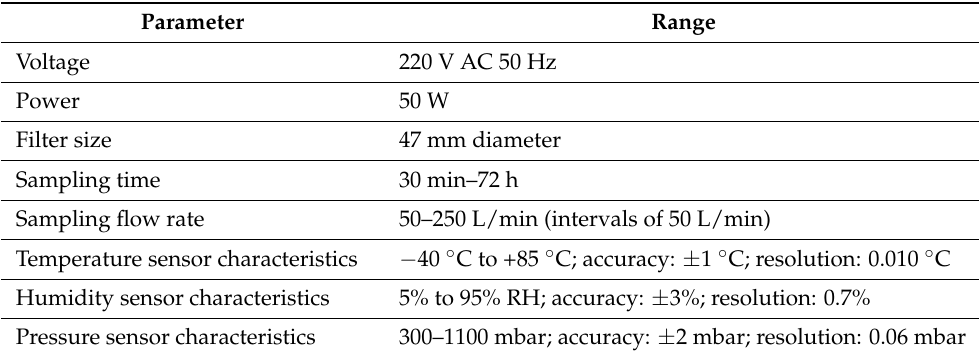
Table 1. Specifications of the bioaerosol sampler .